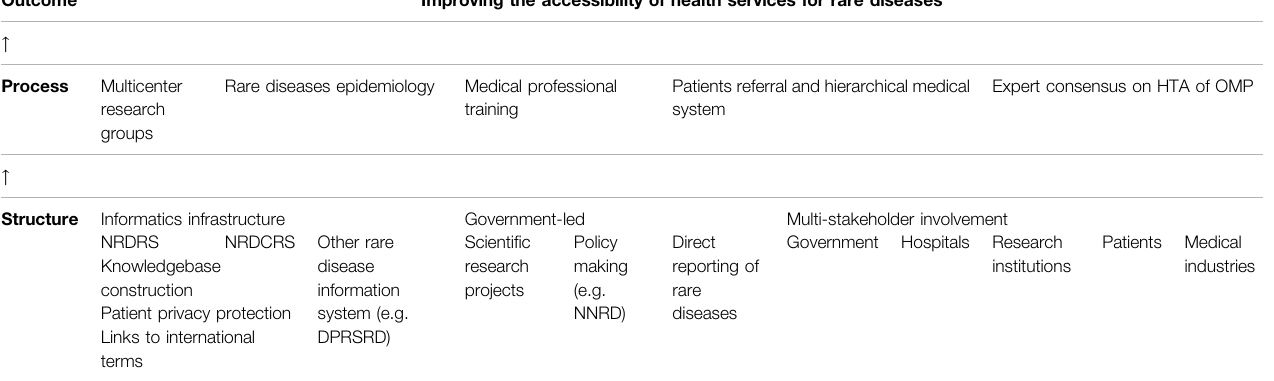
TABLE 1 | The national coordinating strategy for the management of rare